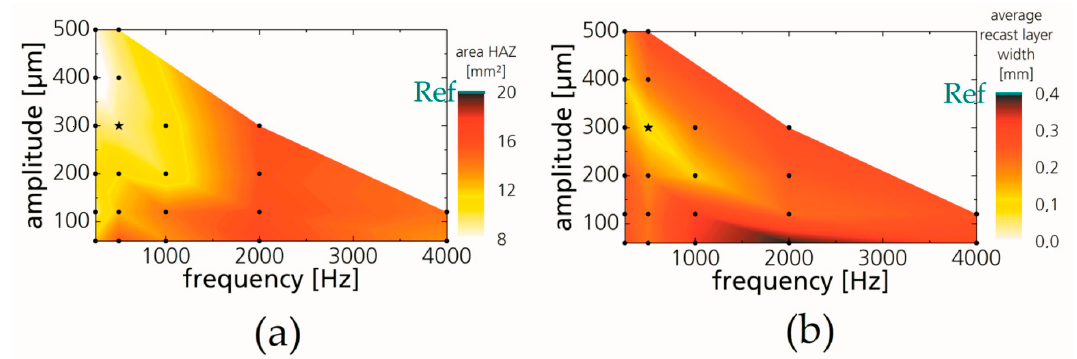
Figure 7. Contour plots of: ( a ) HAZ area; ( b ) Average recast layer width for 12 mm mild steel as a function of the oscillation frequency and amplitude. The stars denote the best cutting result. The reference values (Ref) correspond to the values obtained with static beam shaping.